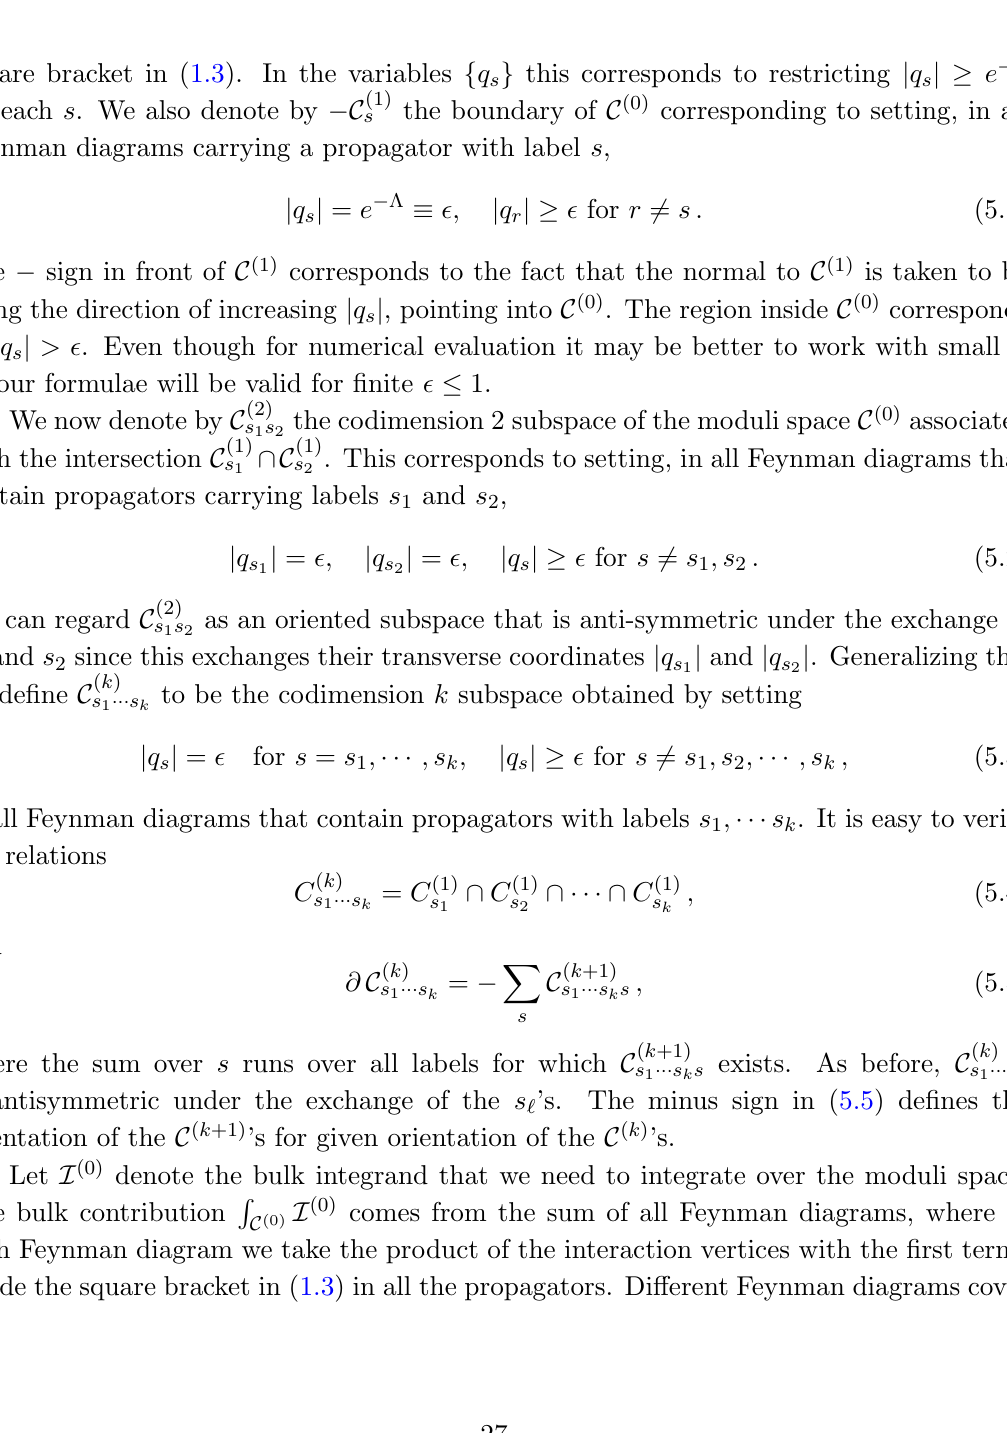
j (cid:21) e (cid:0) (cid:3) s